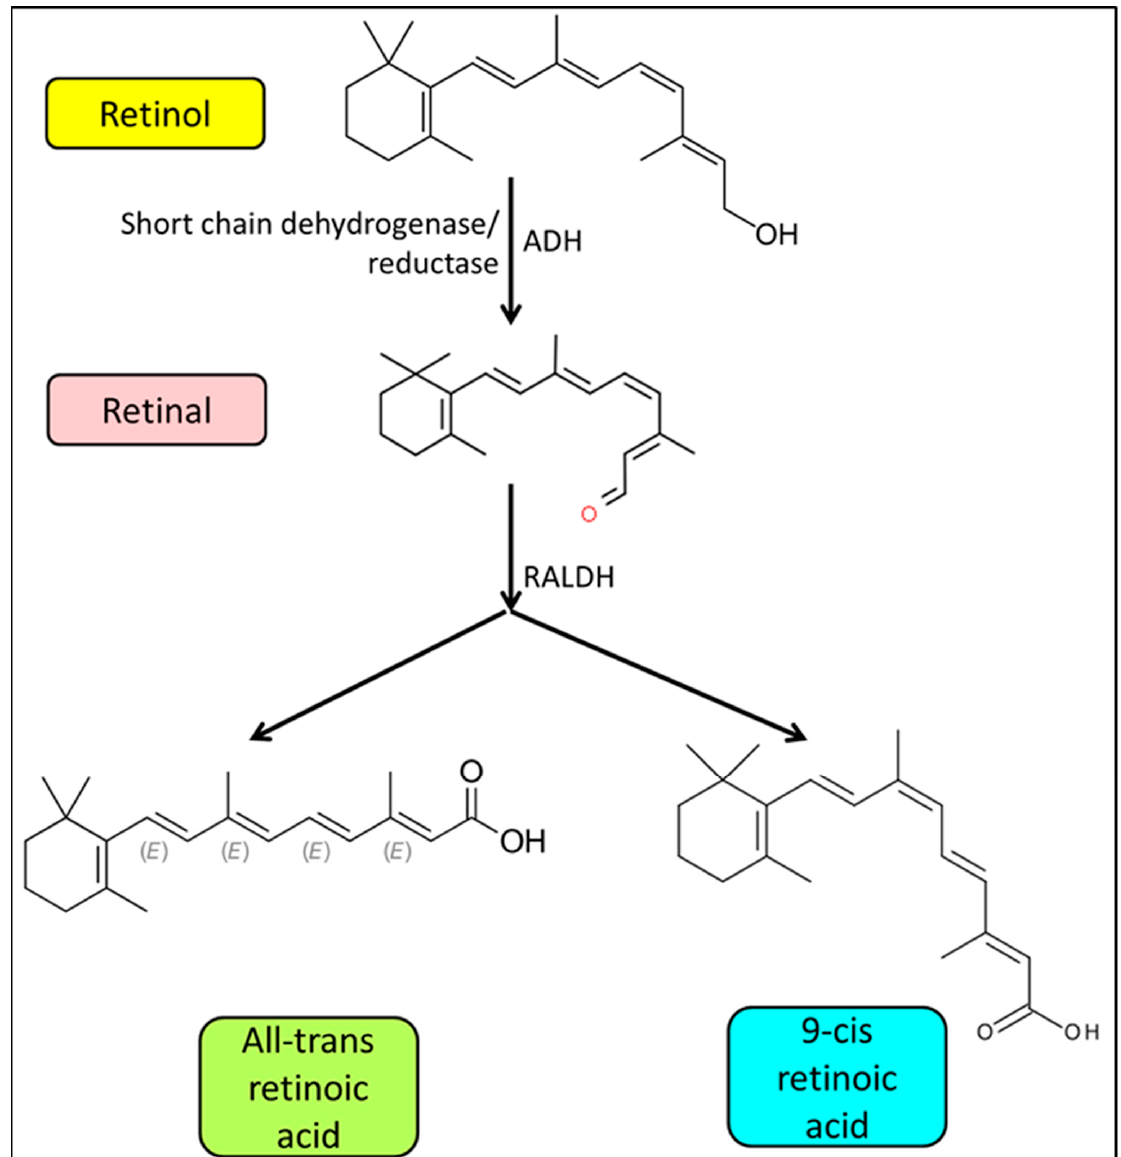
Figure 2. The oxidative process that is required to convert inactive retinol into useful retinoic acid takes place in two stages. Where, ADH, alcohol dehydrogenases; RALDH, retinaldehyde dehydro- genase.